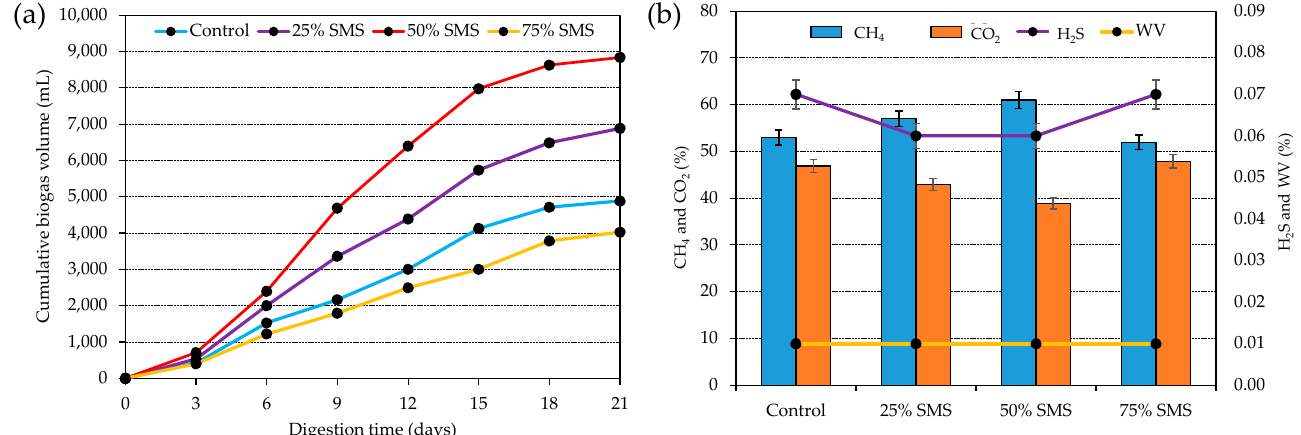
Figure 4. Cumulative volume (mL) ( a ) and composition ( b ) of biogas produced using different treatments of Shiitake SMS and CD (CO 2 : carbon dioxide; H 2 S: hydrogen sulfide; WV: water vapor).